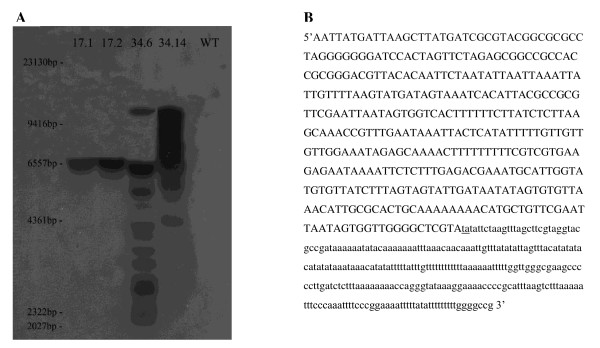
Molecular characterisation of insertions. (A). Southern analysis confirms transgene integration. DNA was extracted from individuals from four G1 individual derived lines carrying the transgene (17.1, 17.2, 34.6 & 34.14) and digested with EcoRI. The probe was generated from the NotI/SalI fragment of pMi[3xP3-EGFP]. DNA from wild-type (WT) individuals was included as a control. For lines 17.1 and 17.2 single bands of the same size (approximately 6500 bp) are present. For lines 34.6 and 34.14 the multiple bands are indicative of multiple inserts at different locations in the genome. No bands are present in wild-type DNA. (B). Flanking sequence of right arm of an insert present in subline 34.6. The pMi[3xP3-EGFP] sequence is shown in upper case and the flanking genomic sequence in lower case. TA duplication, characteristic of a Minos mediated insertion event, is underlined.